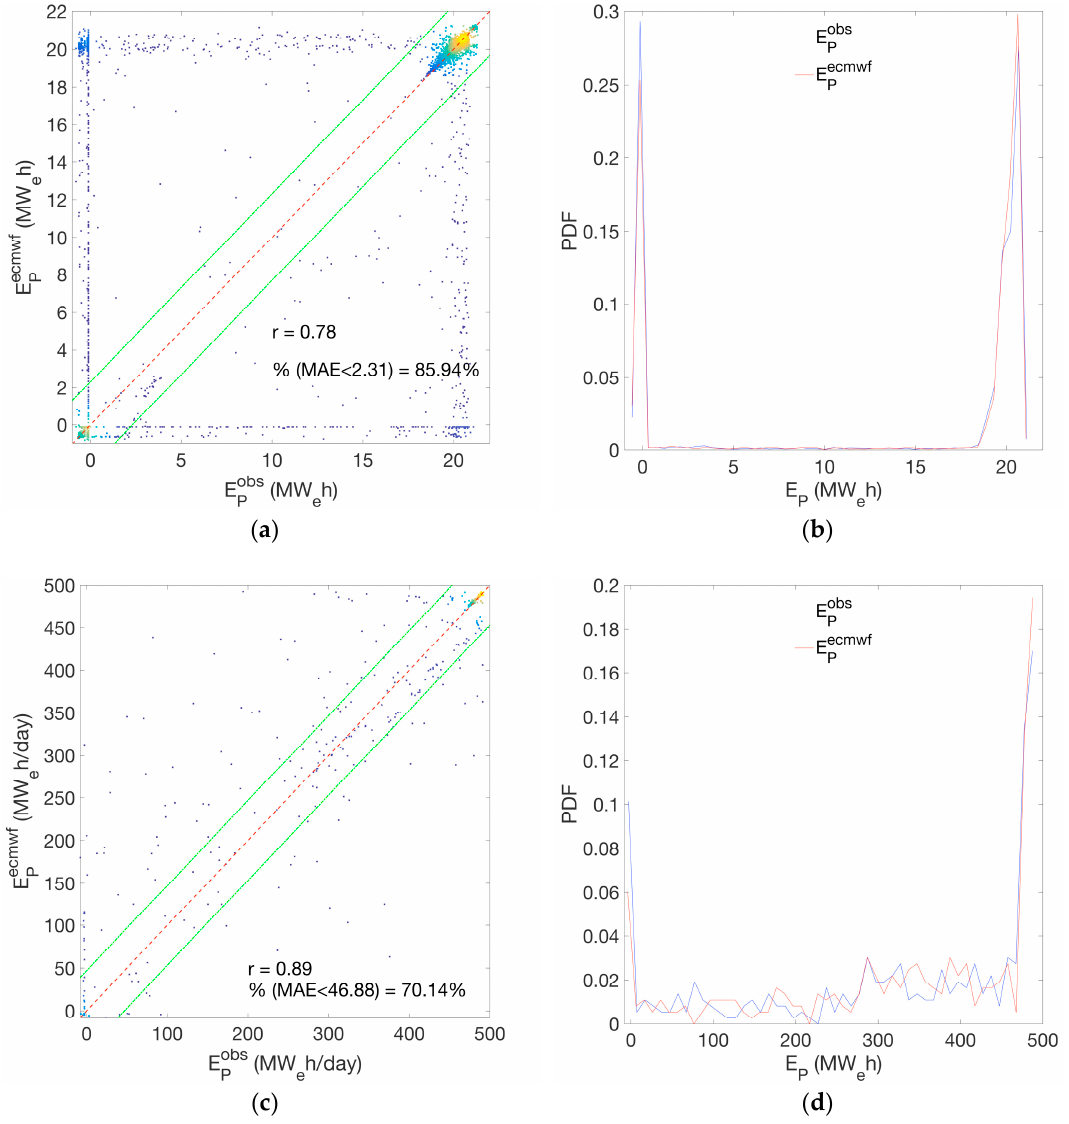
Figure 2. Estimated hourly ( a , b ) and daily ( c , d ) values of electric energies into the grid, E P (MW e h), and respective probability density functions (PDF), computed from forecasted (ecmwf) and measured (obs) data at Évora. Hourly values of direct normal irradiance (DNI) were used in the SAM to simulate the E P from a central receiver (CR) power plant with configuration similar to the Gemasolar plant (Sevilla, Spain). In the scatter plots, identity lines (red dashed lines), corresponding correlation coefficients, r, and an interval defined by the calculated MAE ( ≈ 2.31 MW e h), given by two green dashed–dotted lines, are shown. The period of study corresponds to one year, from 1 July, 2017 to 30 June, 2018.